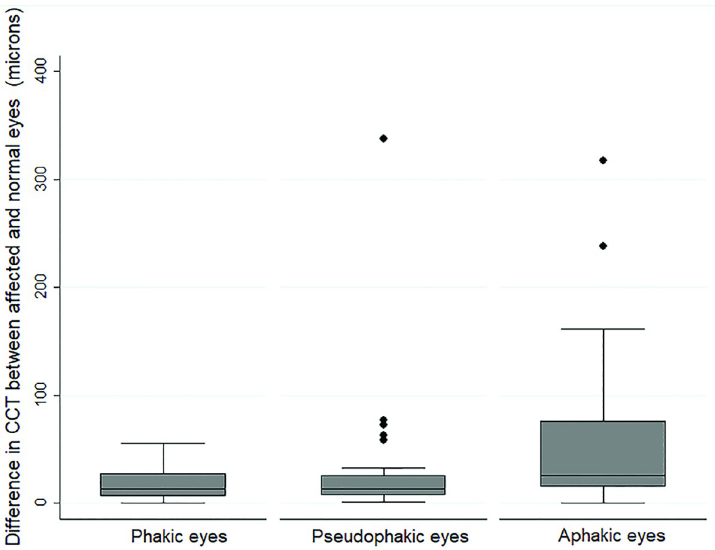
Fig 2. Boxplot of Δ central corneal thickness (CCT) after vitrectomy in eyes with different lens status showing maximum Δ CCT in aphakic eyes. (See text for description of Δ